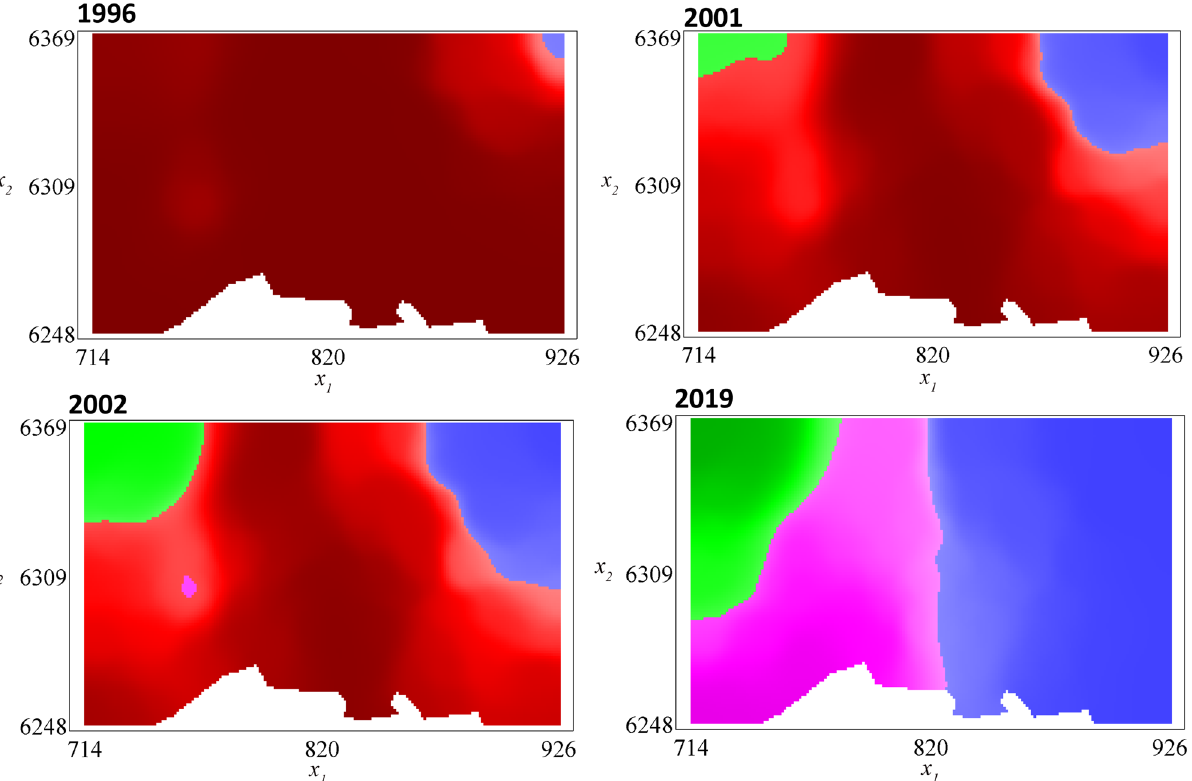
Figure 3. Simulated proportions of the classical and emerging strains in the landscape: before and after the observation window. The simulation results presented here correspond to the middle of the intra-annual stage (2nd week of June), and were obtained with the MLE (cid:31) ∗ . The colors of the shaded regions indicate which strain is the most prevalent. The red regions correspond to the classical strain; blue: ES 1, ES 2 (these two strains have the same density, only ES 1 is represented); green: ES 3 ; pink: ES 4